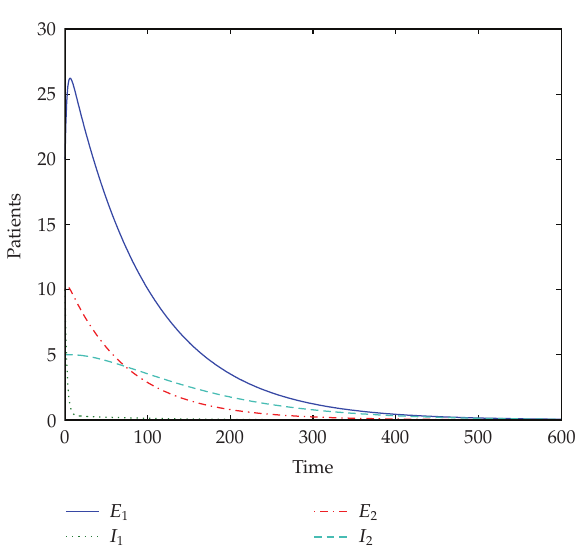
Figure 3: Trajectories of system (cid:2) 2.2 (cid:3) when β 1 (cid:2) N (cid:3) (cid:8) β 1 /N , β 2 (cid:2) N (cid:3) (cid:8) β 2 /N , β 1 (cid:8) 0 . 001, β 2 (cid:8) 0 . 0001, d 1 (cid:8) d 2 (cid:8) 0, so that R 1 < 1, R 2 < 1. It shows that the disease-free equilibrium P 0 is stable.